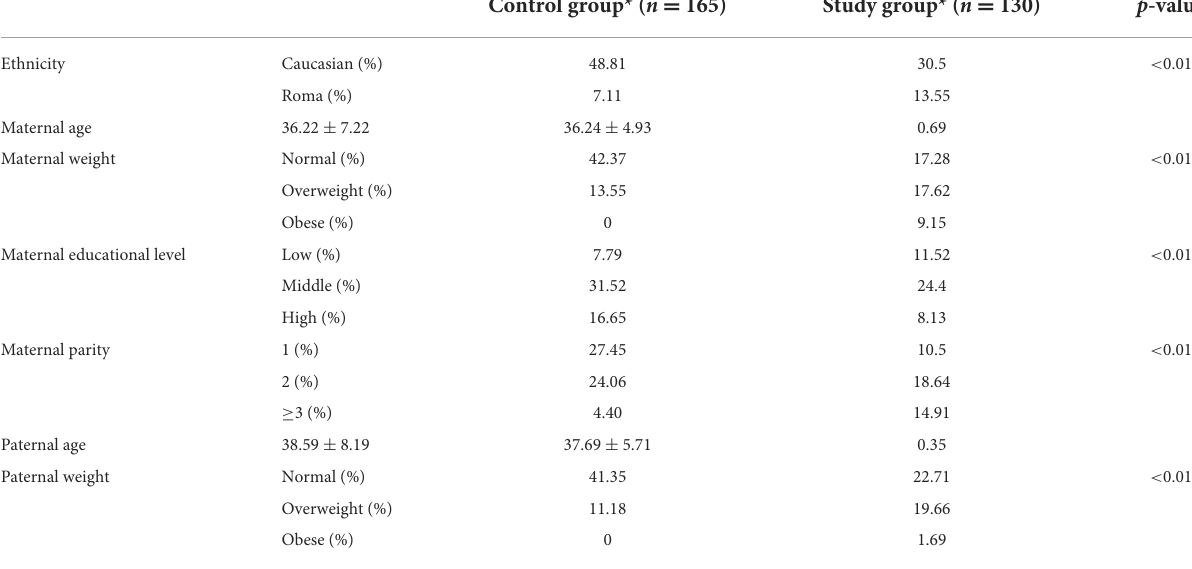
TABLE 3 Comparison of ethnicity, parental weight, age, maternal, parity and educational level between the two study groups. Control group* ( n = 165)